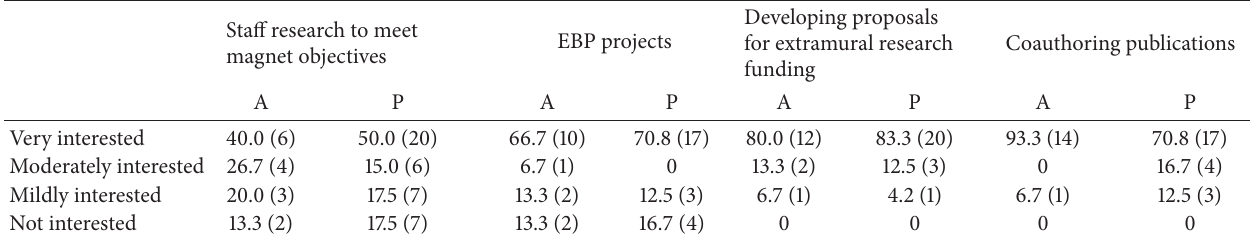
Table 3: Interest in types of collaborations among academic (A) and practice (P) based participants, % (𝑁) .